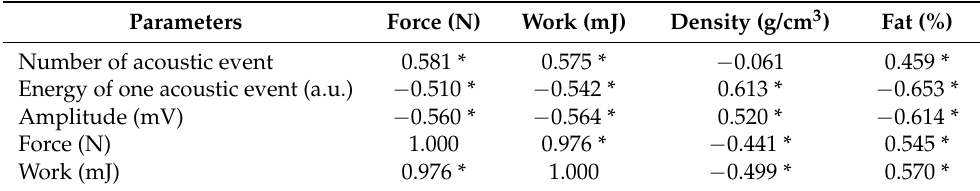
Table 4. The correlations between texture properties, density, and